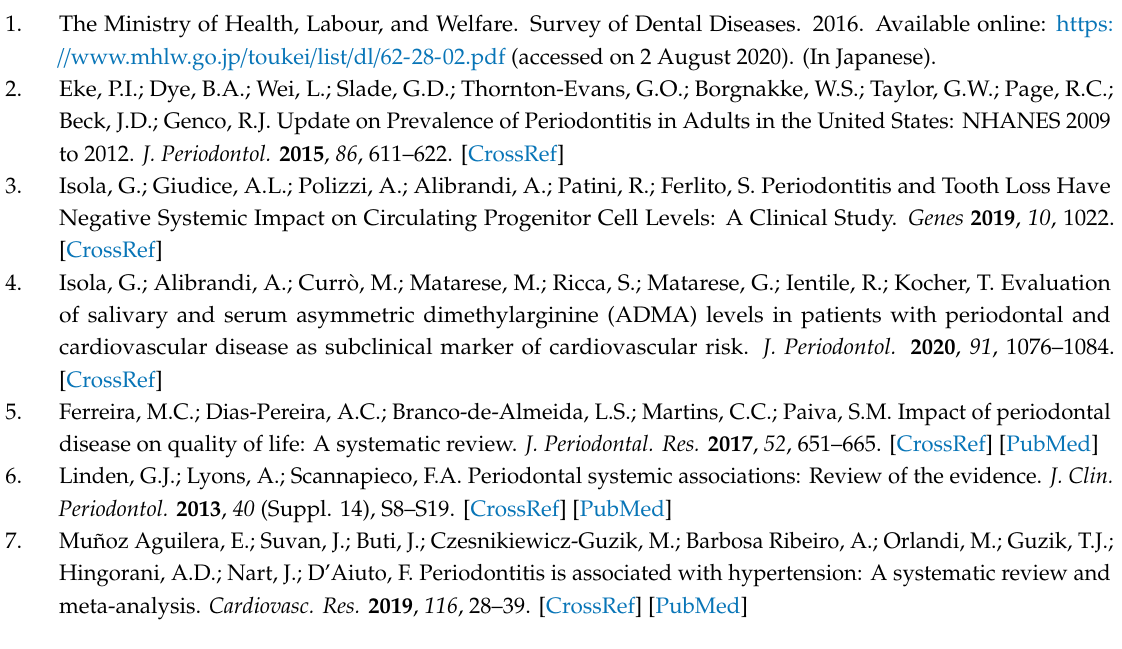
Figure S1: Receiver operating characteristic curve of the TLP-AA-Kit score for severe periodontitis among participants without a smoking habit, obesity, or diabetes, Table S1: Sensitivity, specificity, correct classification, and positive and negative likelihood ratios of the TLP-AA-Kit score for severe periodontitis among participants without a smoking habit, obesity, or diabetes ( n =